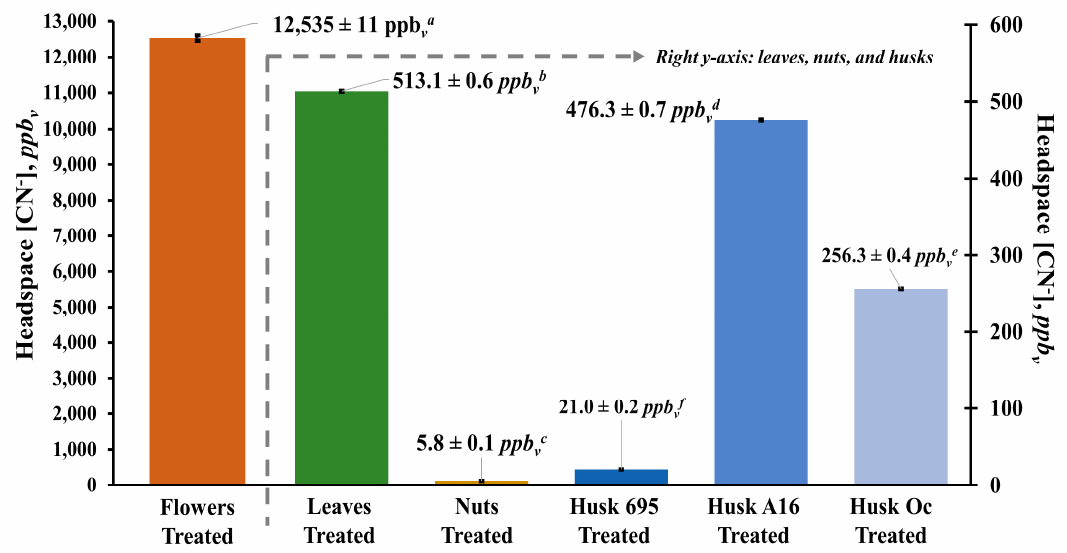
Figure 5. Hydrogen cyanide (HCN) concentration directly analyzed in the headspace of Macadamia flowers, leaves, nuts, and three varieties of Macadamia husks (695, A16, and Oc) treated with Na 2 HPO 4 –citric acid mixture buffered at pH 7 and heated at 50 °C for 60 min. Different superscript letters ( a, b, c, d, e, or f ) indicate significant differences in mean HCN concentration at p < 0.05 (95% confidence intervals).